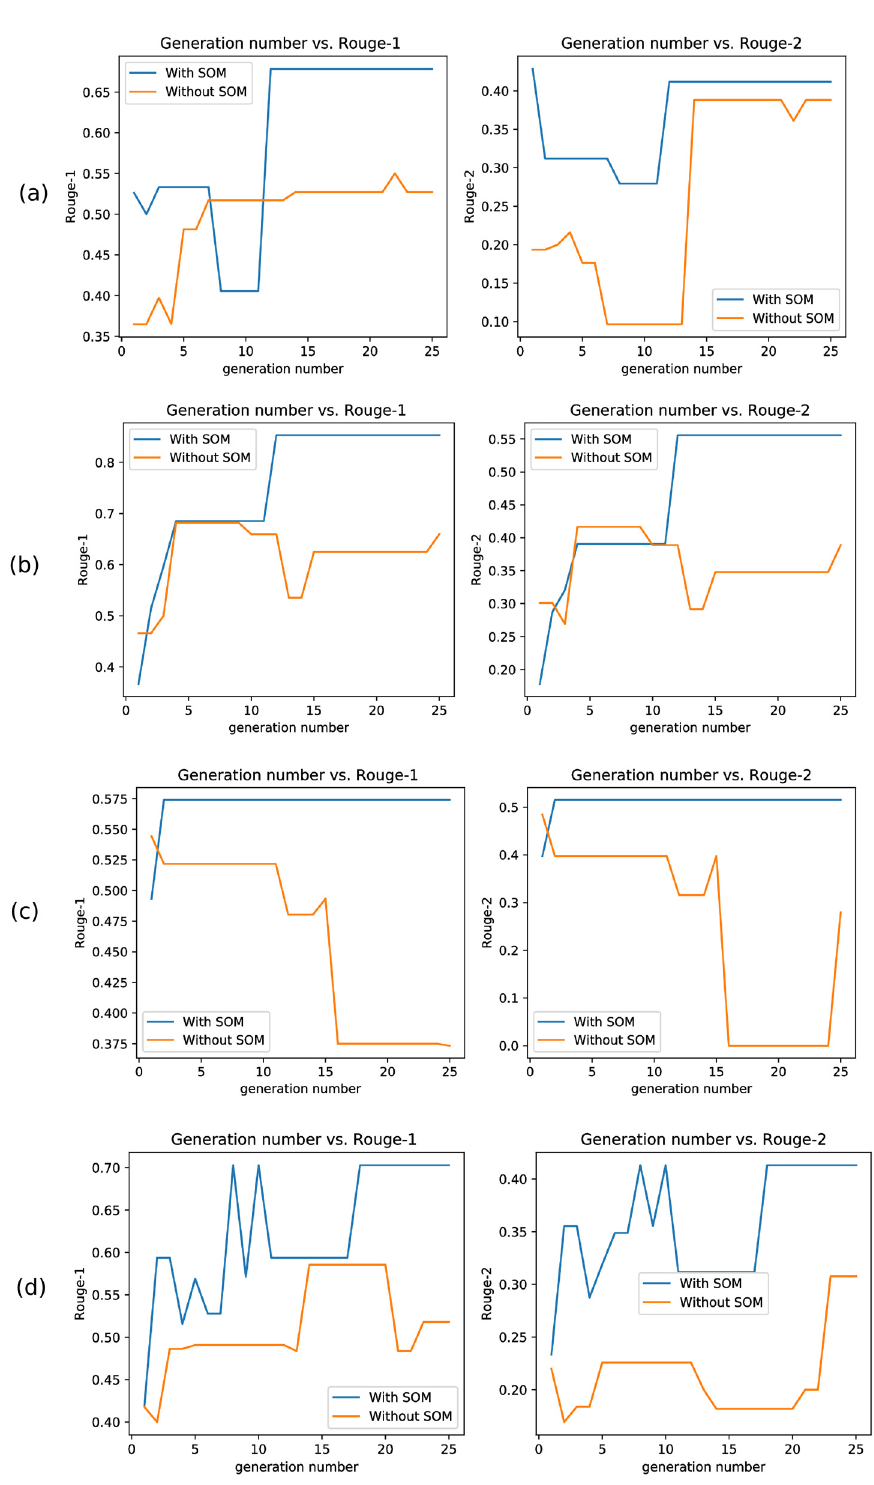
Fig 4. Convergence plots. Sub-figures (a), (b), (c) and (d) show the convergence plots for four random documents. At each generation/iteration, maximum Rouge-1 and Rouge-2 scores are plotted.